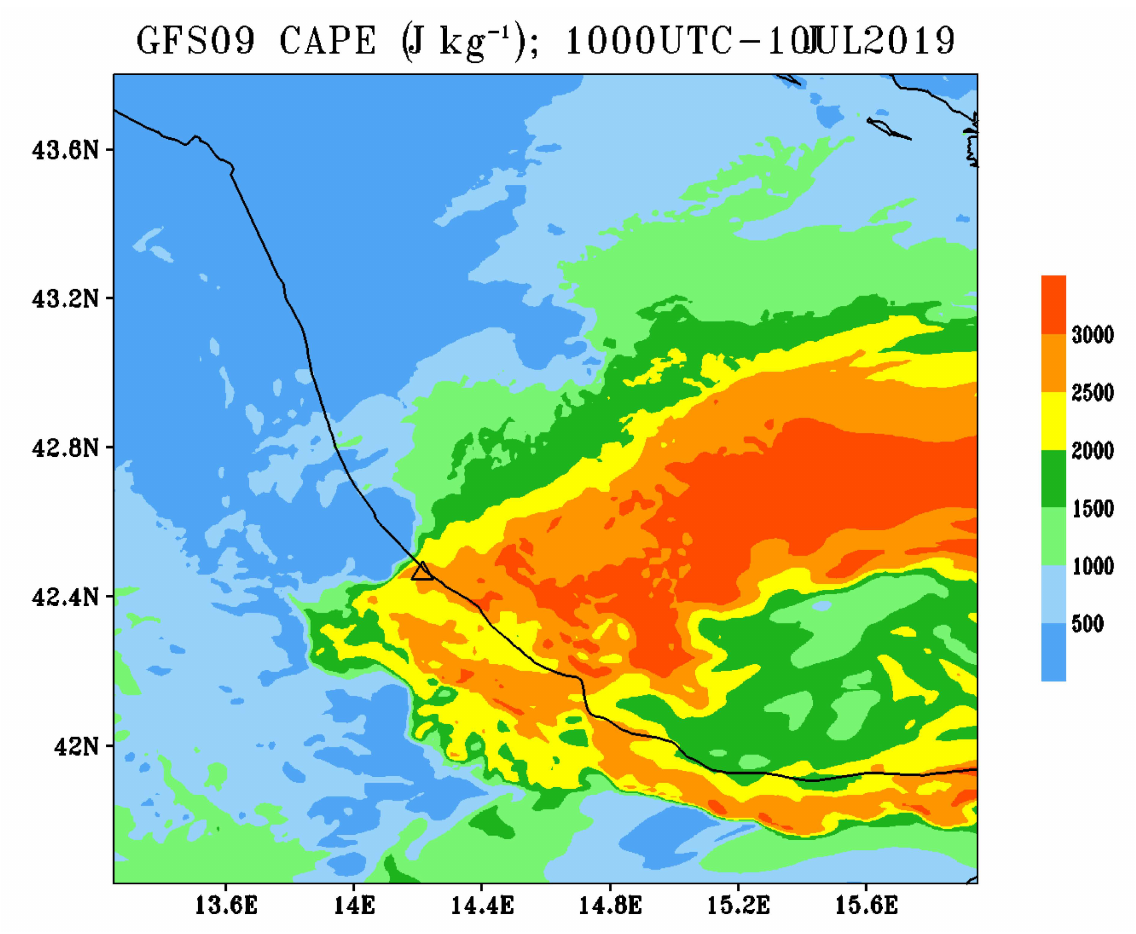
Figure 10. Run GFS09. CAPE at 10:00 UTC, 10 July 2019. A synthetic sounding and a hodograph extracted from the GFS09 run at the grid point closest to the city of Pescara display the modeled vertical structure at 09:00 UTC (Figure 11). The small inversion at about 900 hPa appears to play a fundamental role in preventing the initial release of the very-high potential instability (CAPE higher than 3000 J kg − 1 ). In less than one hour (not shown), the arrival of northerly winds (Figure 9) cools the boundary layer, so that the inhibition is reduced, and convection can be easily triggered by the uplift induced by the cold air boundary. Moreover, a strong directional shear is apparent in the low